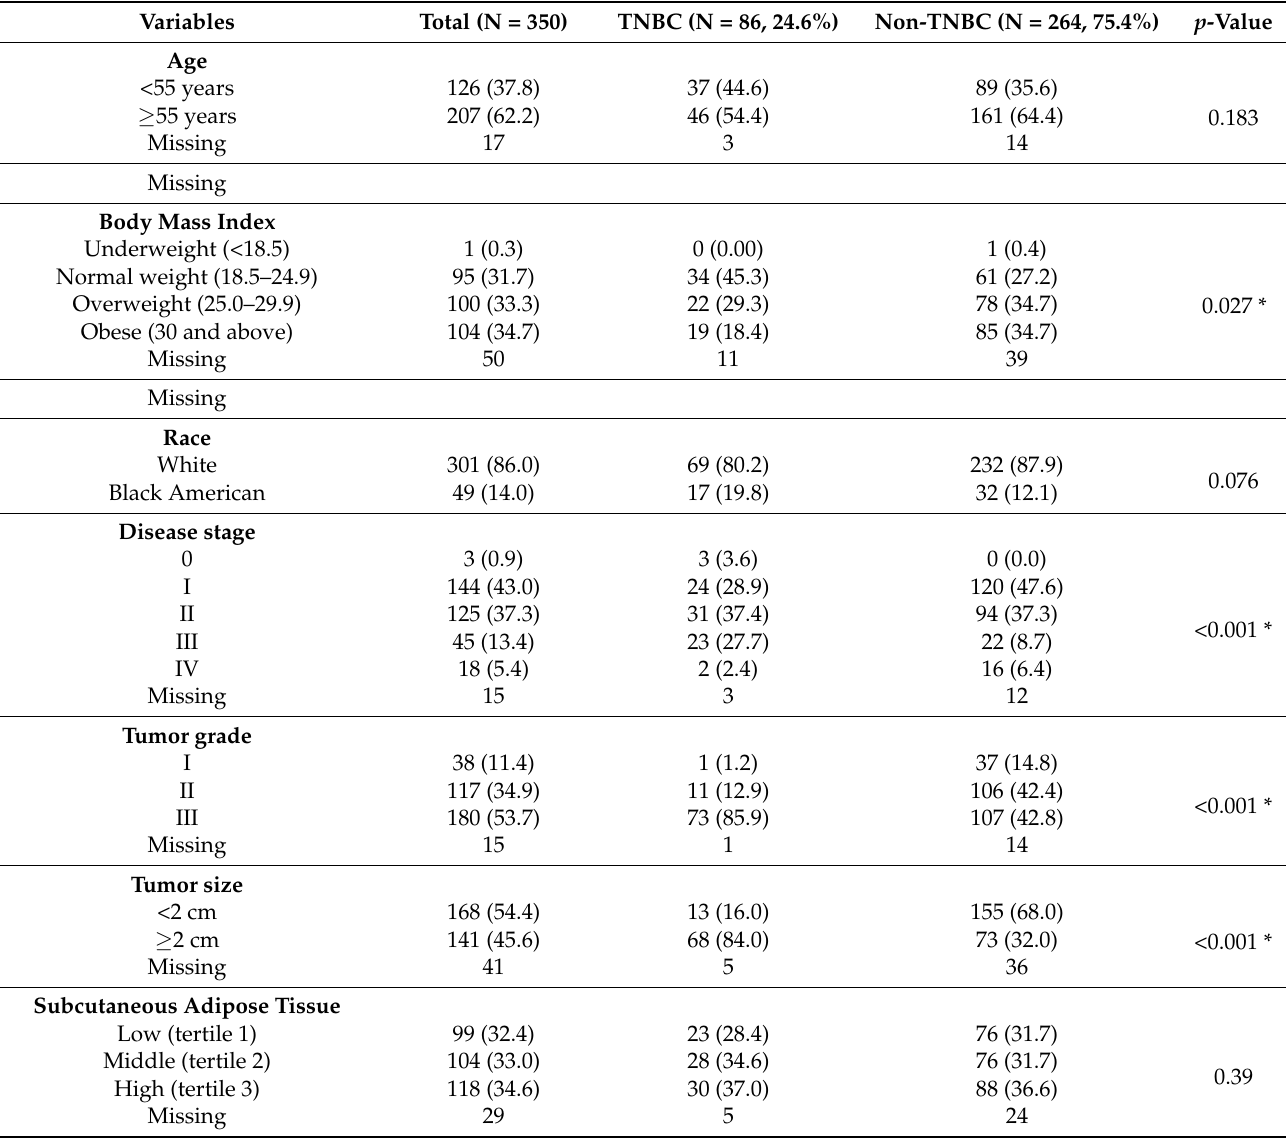
Table 1. Patient and tumor characteristics by Triple-Negative Breast Cancer (TNBC) subtype (N =